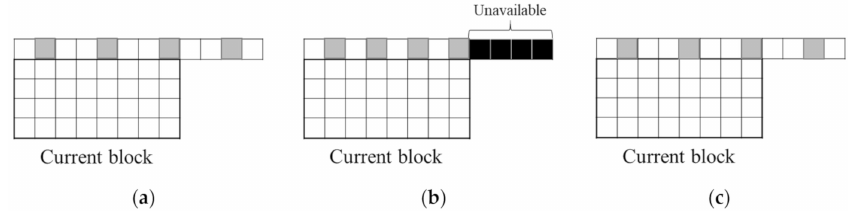
Figure 8. Comparisons of subsampled neighboring sample positions between VTM-6.0 and the proposed CCLM for the T_CCLM mode: ( a ) VTM-6.0 with no unavailable neighboring samples; ( b ) VTM-6.0 with four unavailable neighboring samples; ( c ) the proposed